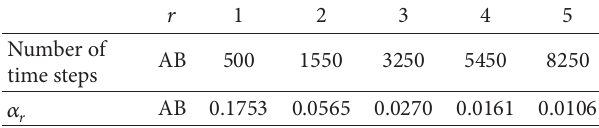
Table 3: Stability conditions for the AB time discretization